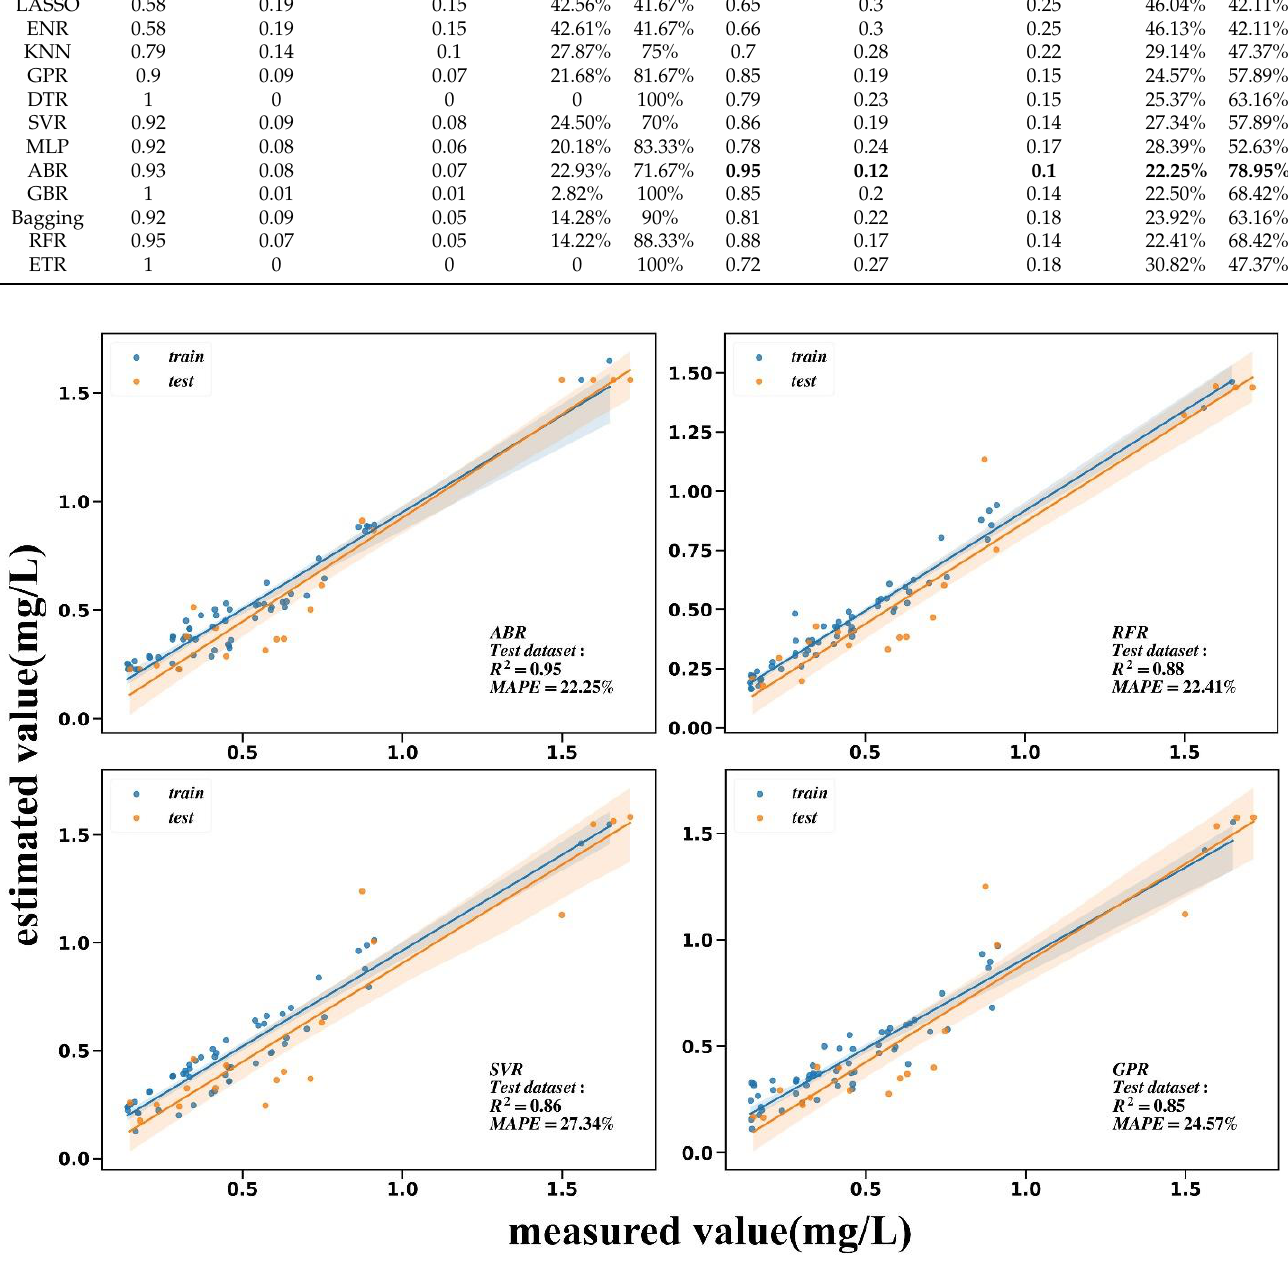
Figure 12. Comparison between the NH3-N measured value and the estimated value of the first four models with the highest R 2 of the test dataset.